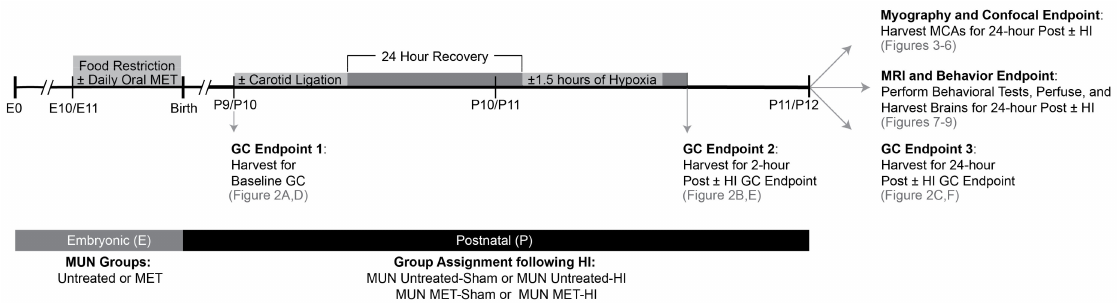
Figure 1. Experimental Overview of Embryonic and Postnatal Events. As indicated in the above diagram (not to scale), all pregnant Sprague–Dawley rats received a diet of 50% caloric reduction beginning at E10 and continuing until term, resulting in maternal undernutrition (MUN). Half of the animals also received a daily oral dose of 0.5 mg/mL of metyrapone (MET) in the drinking water beginning at E11 through term, yielding two groups: the Untreated group (untreated water), and the MET group (MET-treated water). After birth, the euthanization of pups at two specific endpoints (GC Endpoints 1 and 2) followed by trunk blood collection allowed for the determination of plasma glucocorticoid (GC) levels before and immediately following hypoxic-ischemic (HI) injury. Plasma collection for the third GC Endpoint, artery harvesting for myography and future confocal measurements, and behavioral testing followed by perfusion fixation for future ex vivo MRI evaluation occurred in cohorts of P11/P12 rats 24 h following HI